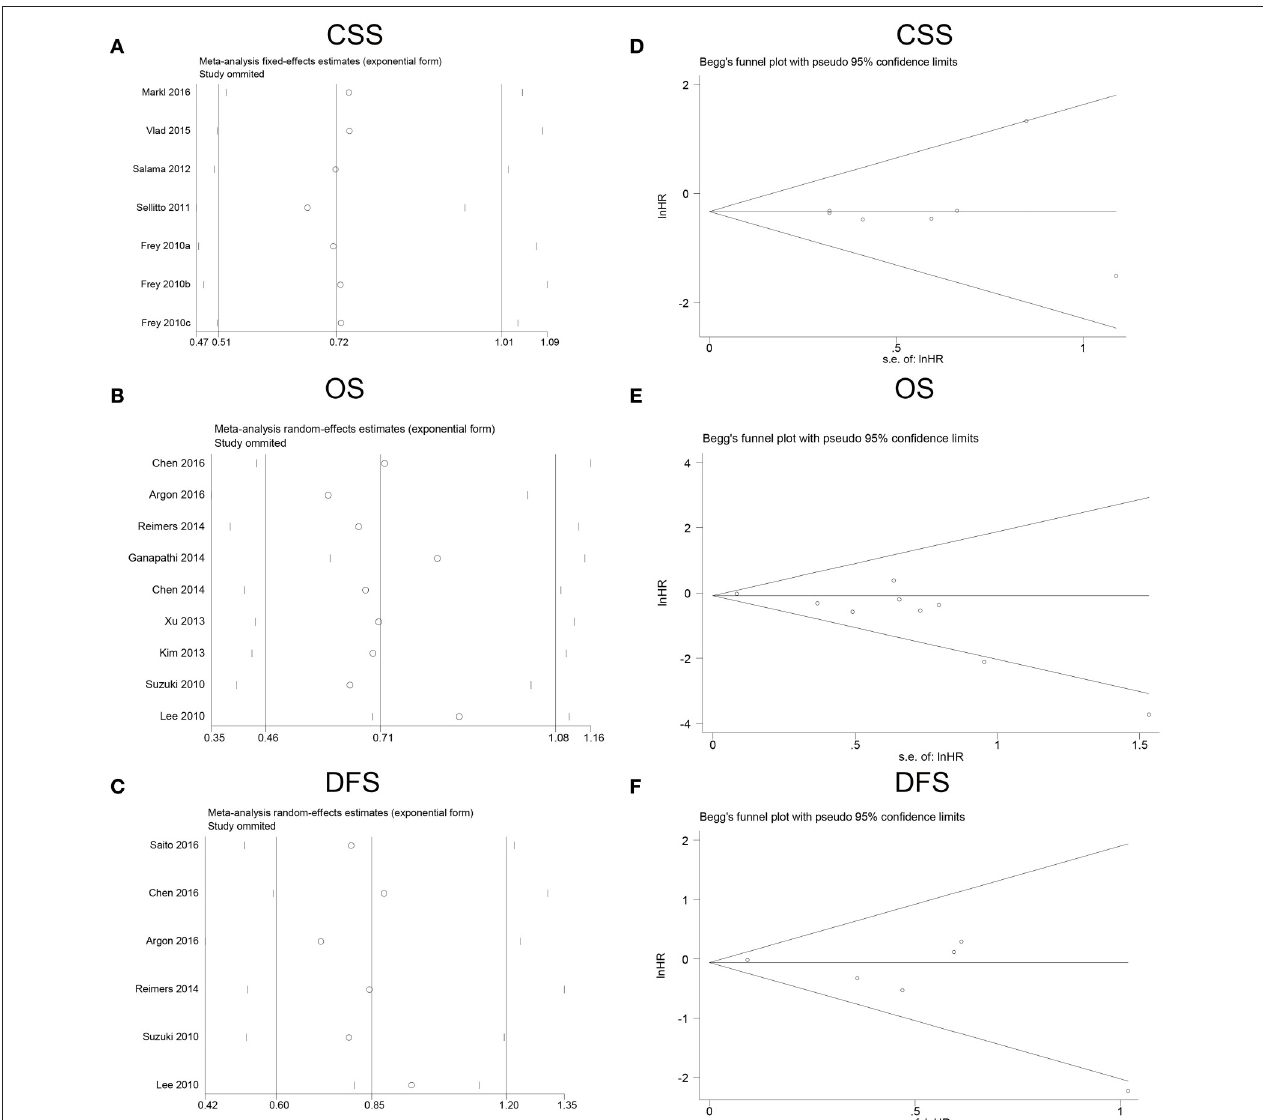
FIGURE 5 | Sensitivity analyses and funnel plots for the publication bias of FoxP3 + Tregs on survival. (A) Sensitivity analysis for CSS; (B) sensitivity analysis for OS; (C) sensitivity analysis for DFS; (D) publication bias for CSS; (E) publication bias for OS; (F) publication bias for DFS. FoxP3, Forkhead box P3; Tregs, regulatory T lymphocytes; CSS, cancer-specific survival; OS, overall survival; DFS, disease-free